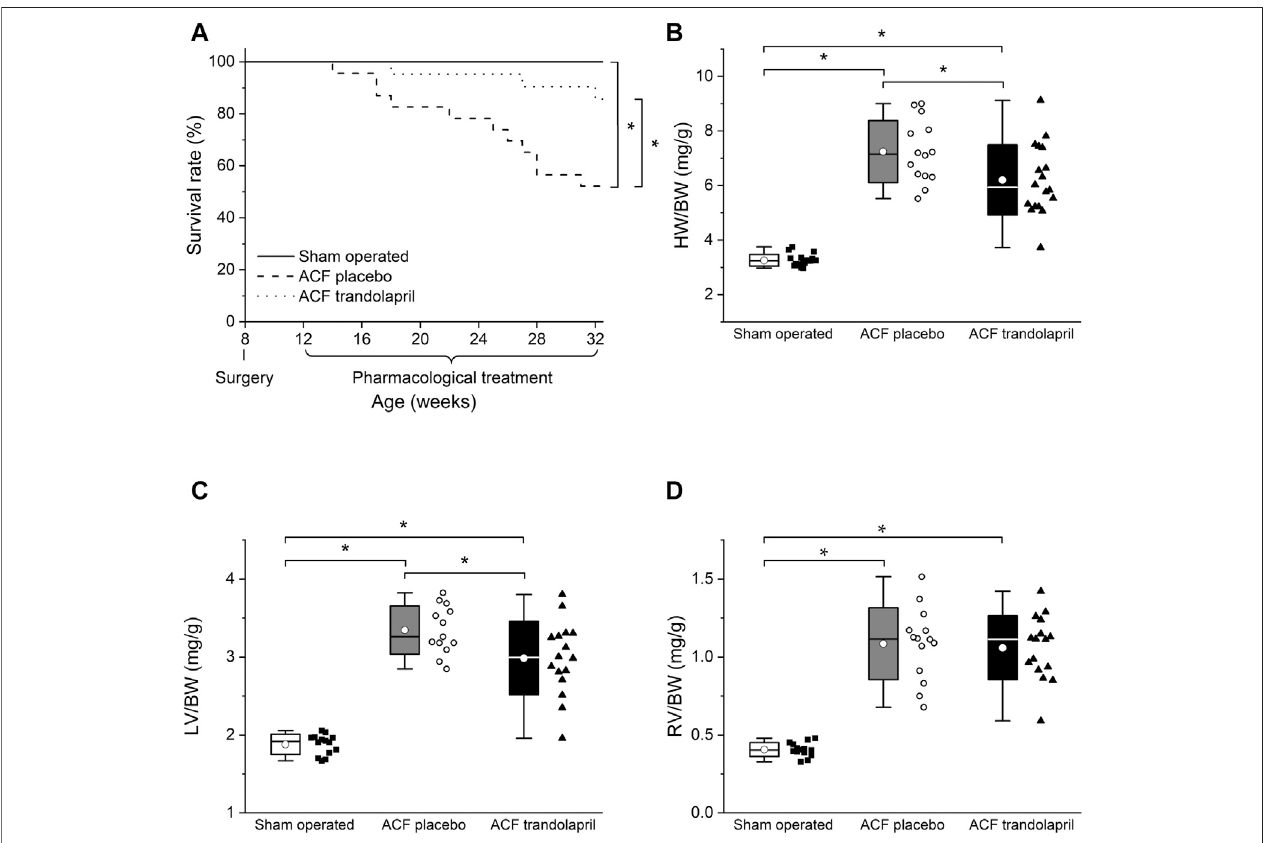
FIGURE1| Survivalandheartweights. (A) Survivalratesinsham-operatedrats( n (cid:1) 18),ACFrats( n (cid:1) 23)andACFratswithtrandolaprl( n (cid:1) 21). (B) Heartweightto body weight ratios in sham-operated rats ( n (cid:1) 12), ACF rats ( n (cid:1) 10) and ACF rats with trandolapril ( n (cid:1) 10). (C) Left ventricle weight to body weight ratios in sham- operated rats ( n (cid:1) 12), ACF rats ( n (cid:1) 10) and ACF rats with trandolapril ( n (cid:1) 10). (D) Right ventricle weight to body weight ratios in sham-operated rats ( n (cid:1) 12), ACF rats ( n (cid:1) 10) and ACF rats with trandolapril ( n (cid:1) 10). * p <